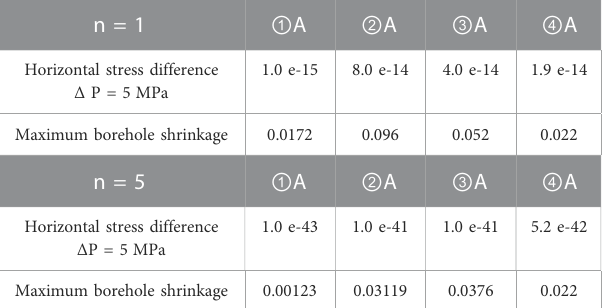
TABLE 3 The pre-coef fi cient A and the exponent n (Layer No. 3), in the case of n = 1 and